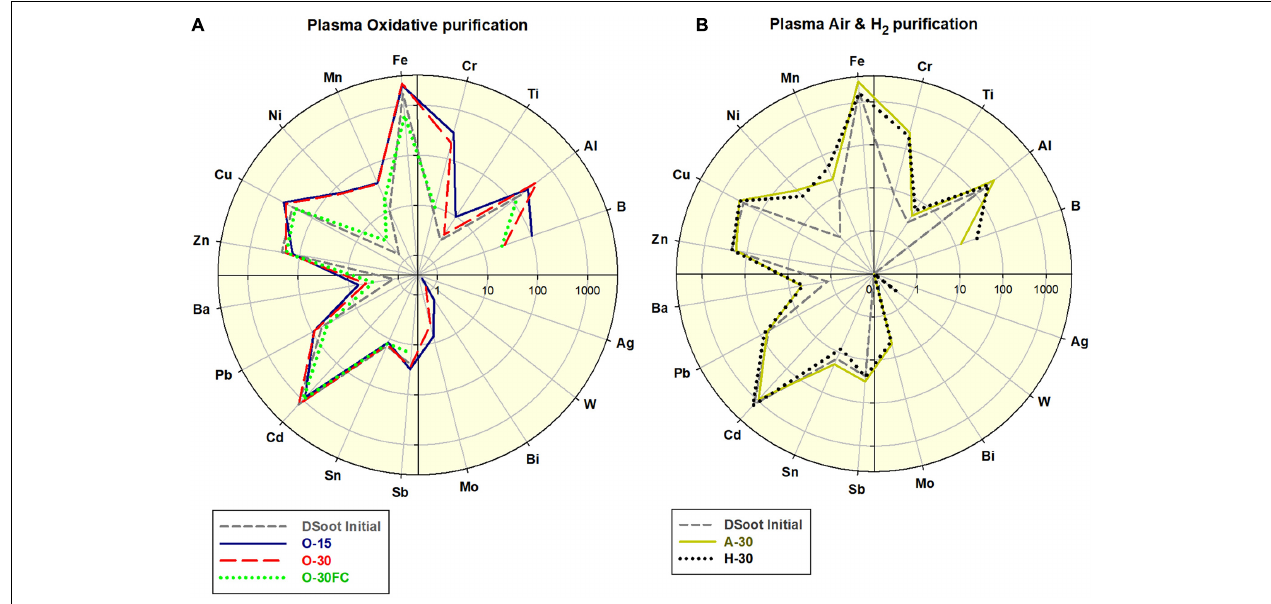
FIGURE 3 | (A) Comparative elemental distribution of O 2 -plasma treated DS; (B) Air- and H 2 -plasma treated DS; scales